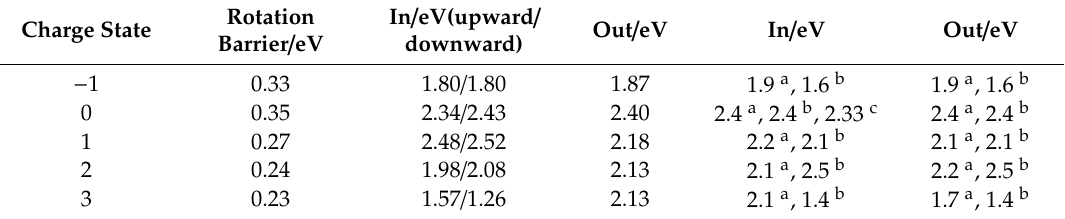
Table 2. Rotation and migration barriers for di ff erent charge states of N i Table 2. Rotation a n d migration barriers for different charge states of N i .